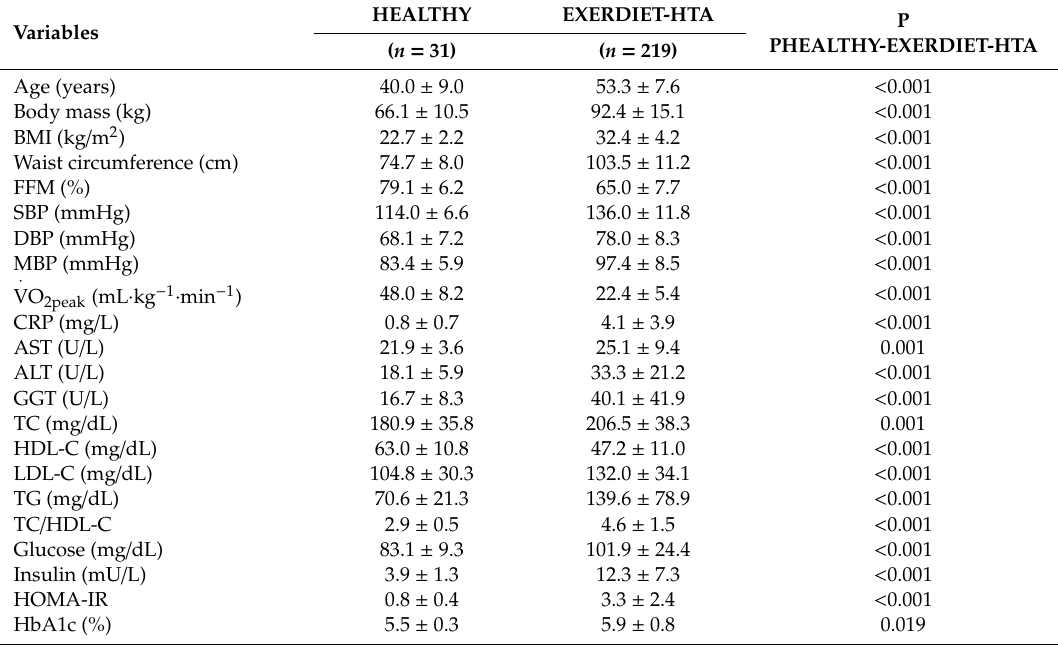
Table 1. Baseline results of the study population compared to a HEALTHY (normal body mass healthy population)